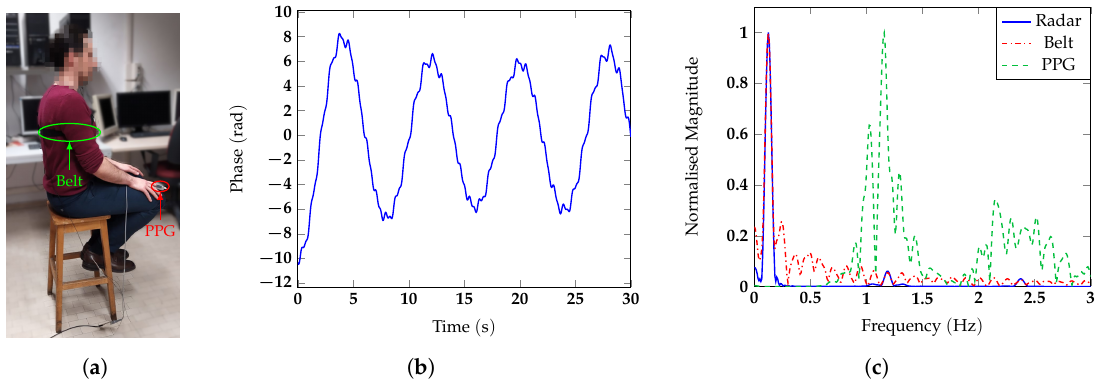
Figure 10. ( a ) Photo of the experimental setup in which the right side of the subject is facing the antenna; ( b ) vital signs extracted by the radar in the time domain and ( c )